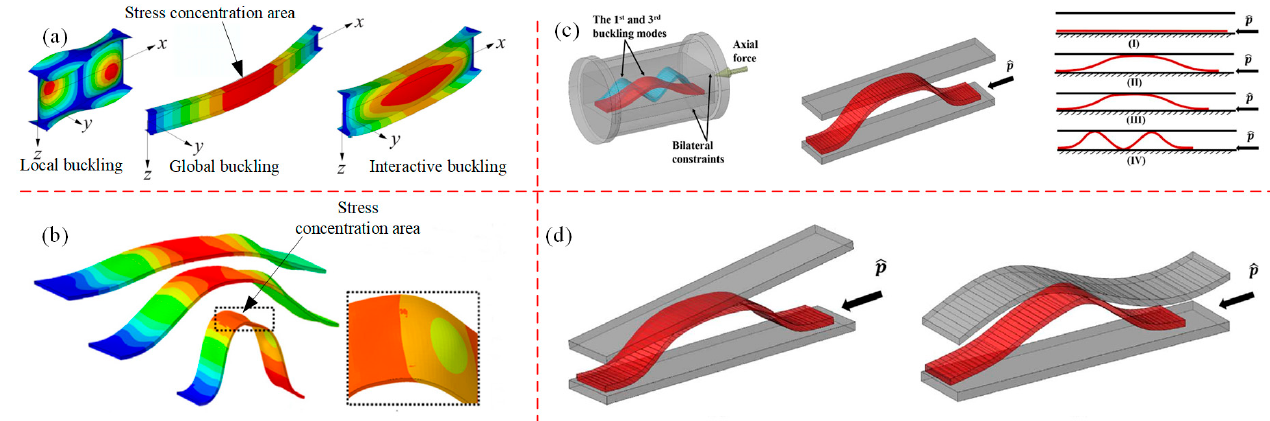
Figure 12. Modes of beam buckling: ( a ) local buckling, global buckling and interactive buckling [155]; ( b ) local buckling of a hollow microstructure beam [156]; ( c ) buckling schematic diagram of a slender beam with irregular bilateral constraints; ( d ) buckling modes of beams under linear and sinusoidal two-sided constraints [157].